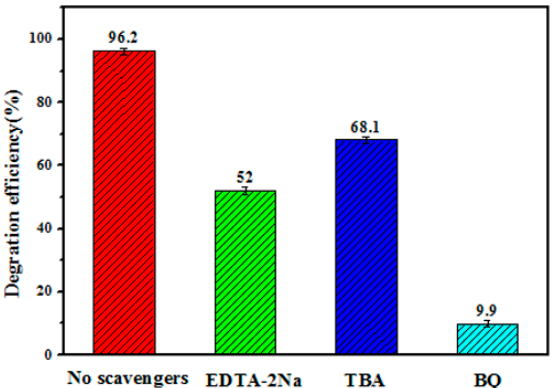
Figure 11. The PEC efficiencies of TC·HCl with different scavengers over the TiO 2 NTs/Ag/MoS 2 : no scavenger; with 1 mM ethylenediamintetraacetic acid disodium (EDTA-2Na); with 1 mM tert-butyl alcohol (TBA); and with 1 mM 1,4-benzoquinone (BQ).